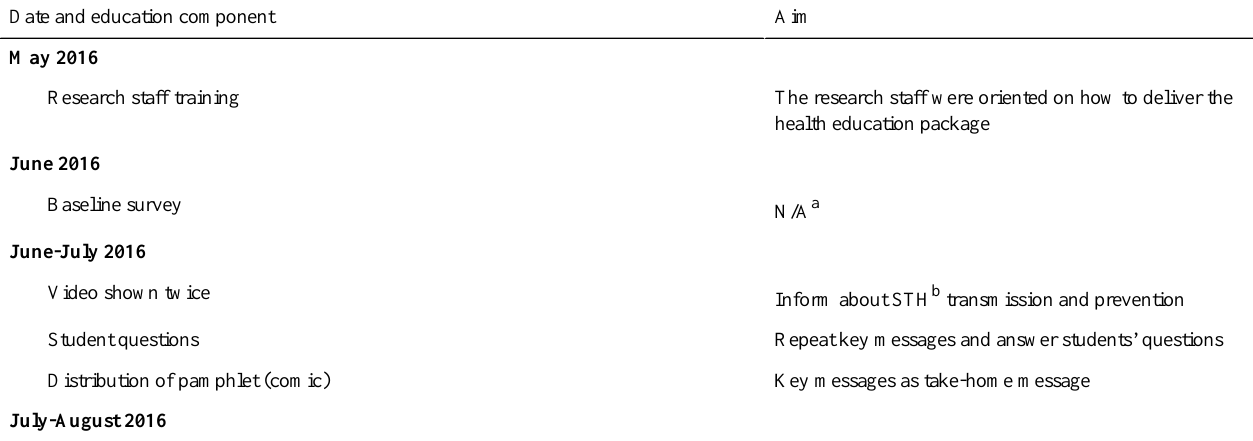
Table 1. Details of the implementation of the health education package for soil-transmitted helminths in the intervention